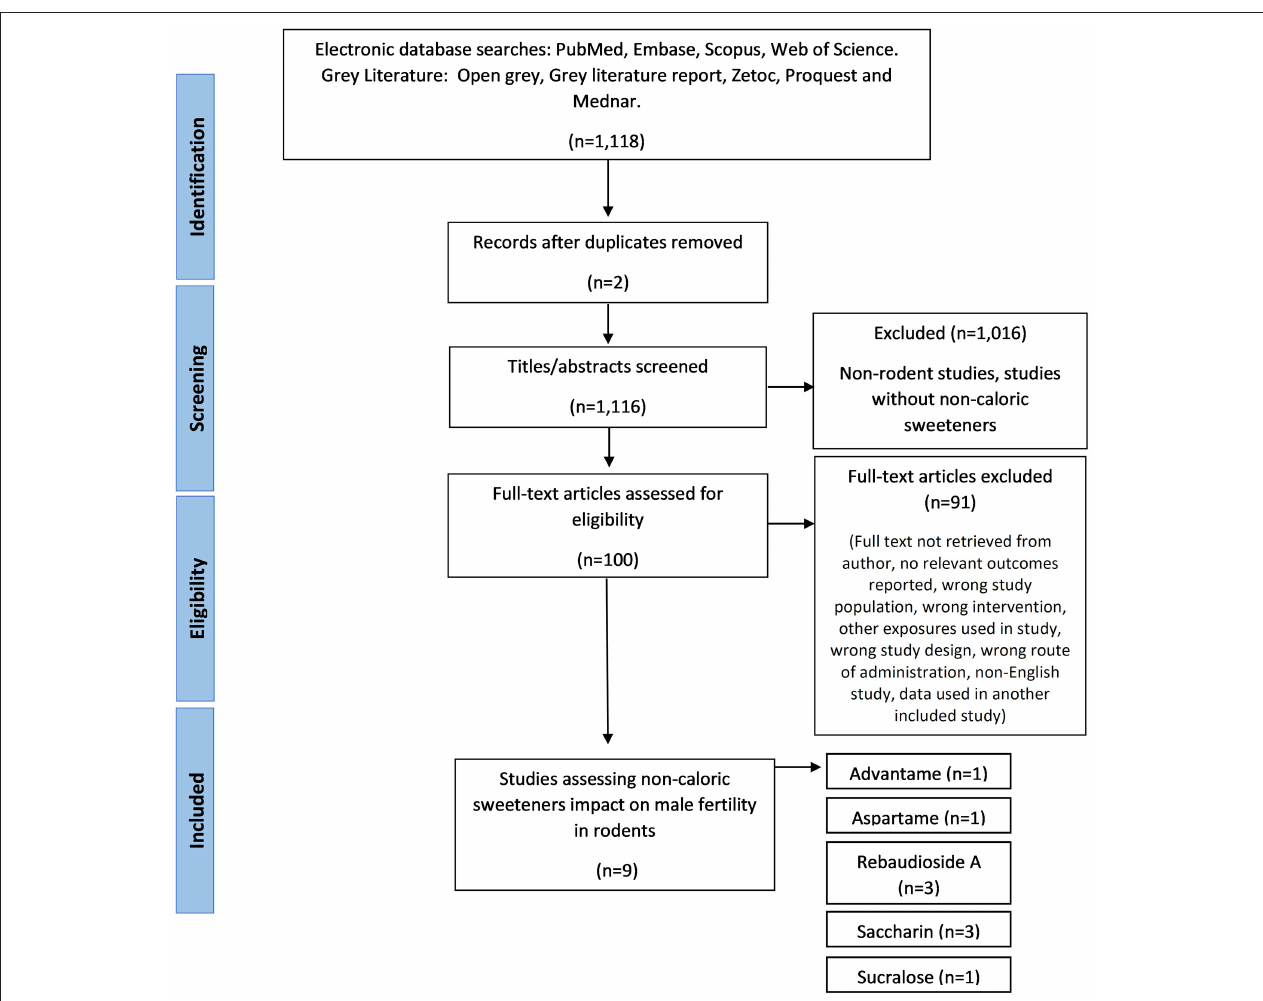
FIGURE 1 | The PRISMA flow diagram for the systematic review detailing the database searches, the number of abstarcts screened, and the full texts retrieved.